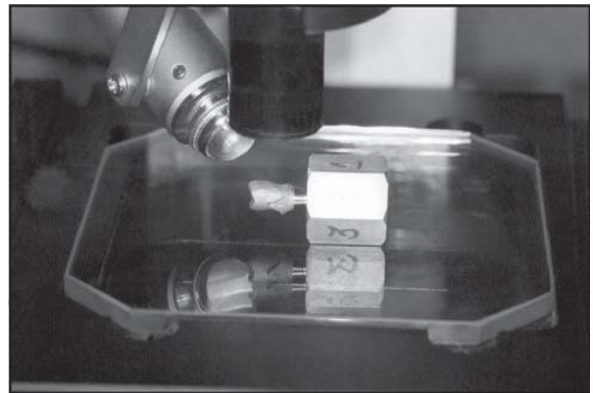
FIGURE 2- Marginal measurement at abutment-cylinder interface